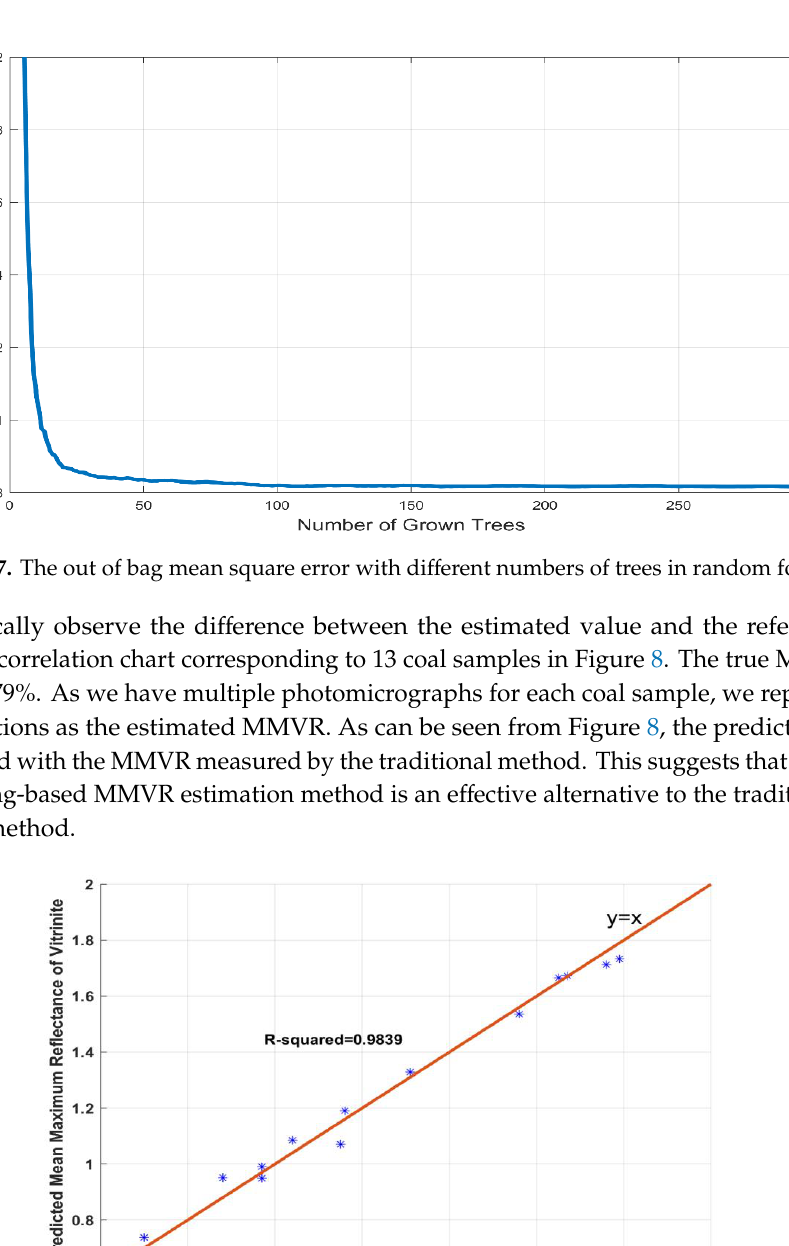
Figure 6. Random forest feature importance chart.